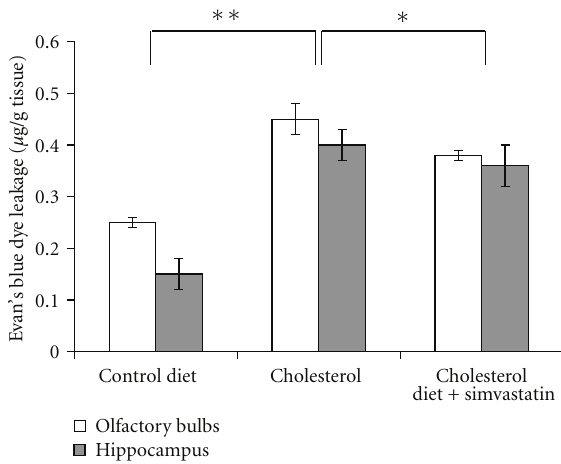
Figure 1: Simvastatin blocks high-cholesterol diet-induced leakage of Evan’s blue dye. New Zealand White rabbits were fed a normal diet (10 weeks) or a high-cholesterol diet (10 weeks) with or without simvasatin (over the final 4 weeks). After treatment, BBB permeability was evaluated by measuring Evan’s blue dye leakage. High-cholesterol diet significantly increased the leakage of Evan’s blue dye into the olfactory bulbs and hippocampus, and these e ff ects were attenuated by treatment with simvastatin (5mg/kg/day during weeks 7–10) ( n = 8, ∗ P < 0 . 05; ∗∗ P < 0 .